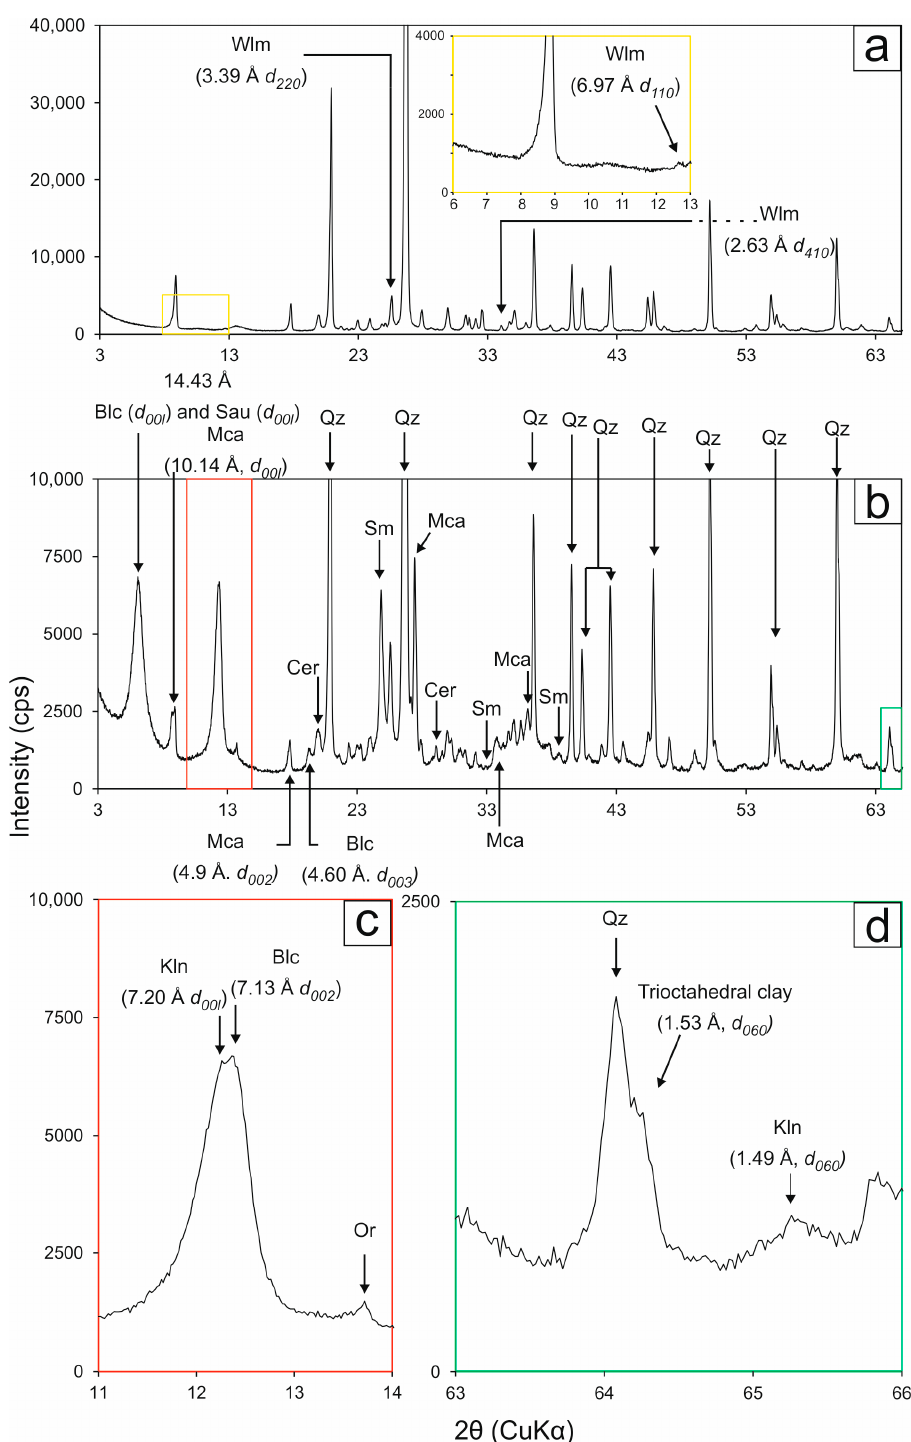
Figure 6. Examples of XRPD patterns of willemite- and baileychlore-bearing samples: ( a ) Sample KDD143-16: XRPD pattern showing characteristic peaks of willemite (other minerals identifiable in the patter are quartz, muscovite and smithsonite; see Table 1); ( b ) Sample KDD143-26: XRPD pattern showing characteristic peaks of major phases occurring in the sample; ( c ) and ( d ) enlargements of ( b ) showing characteristic peaks of baileychlore. Notes: unspiked peaks in the XRPD pattern of sample KDD143-26 correspond to minor reflections of orthoclase. Blc = baileychlore; Cer = cerussite; Kln = kaolinite; Mca = mica (undistinguished; see text for details); Or = orthoclase; Qz = quartz; Sau = sauconite; Wlm = willemite.